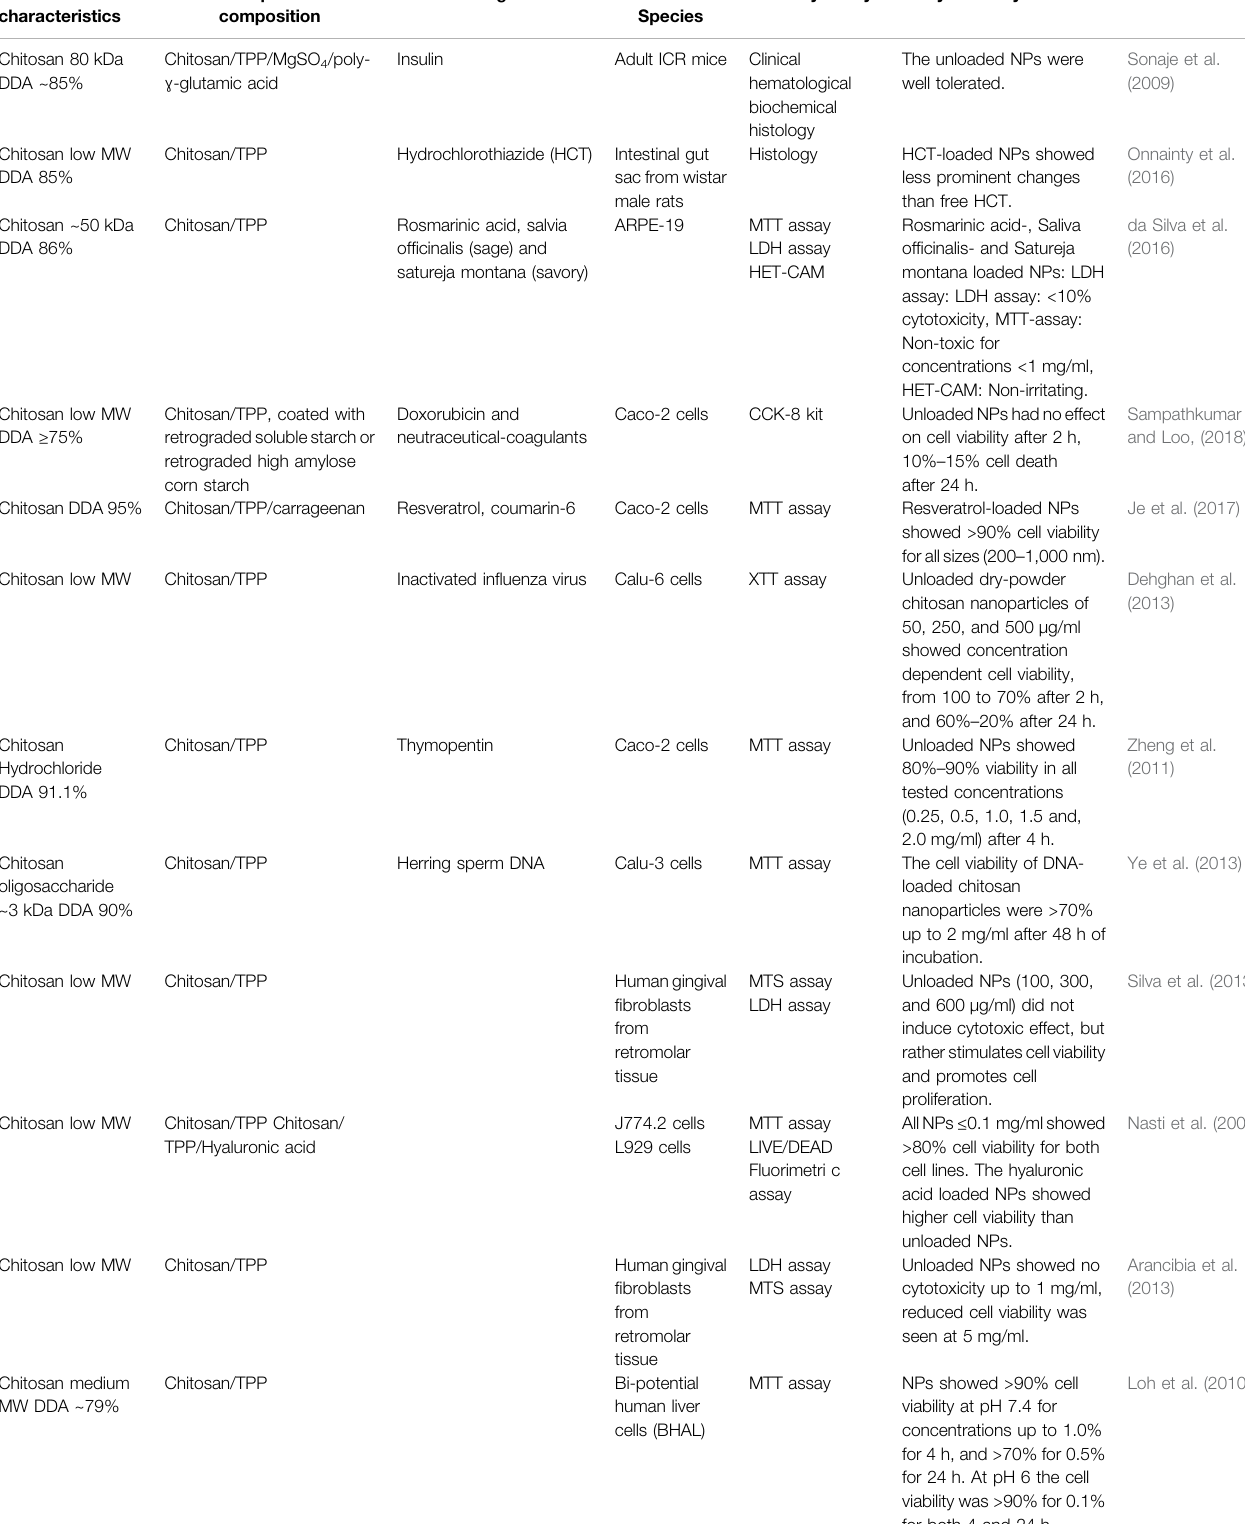
TABLE 1 | Articles on chitosan nanoparticles with TPP as crosslinker, main fi